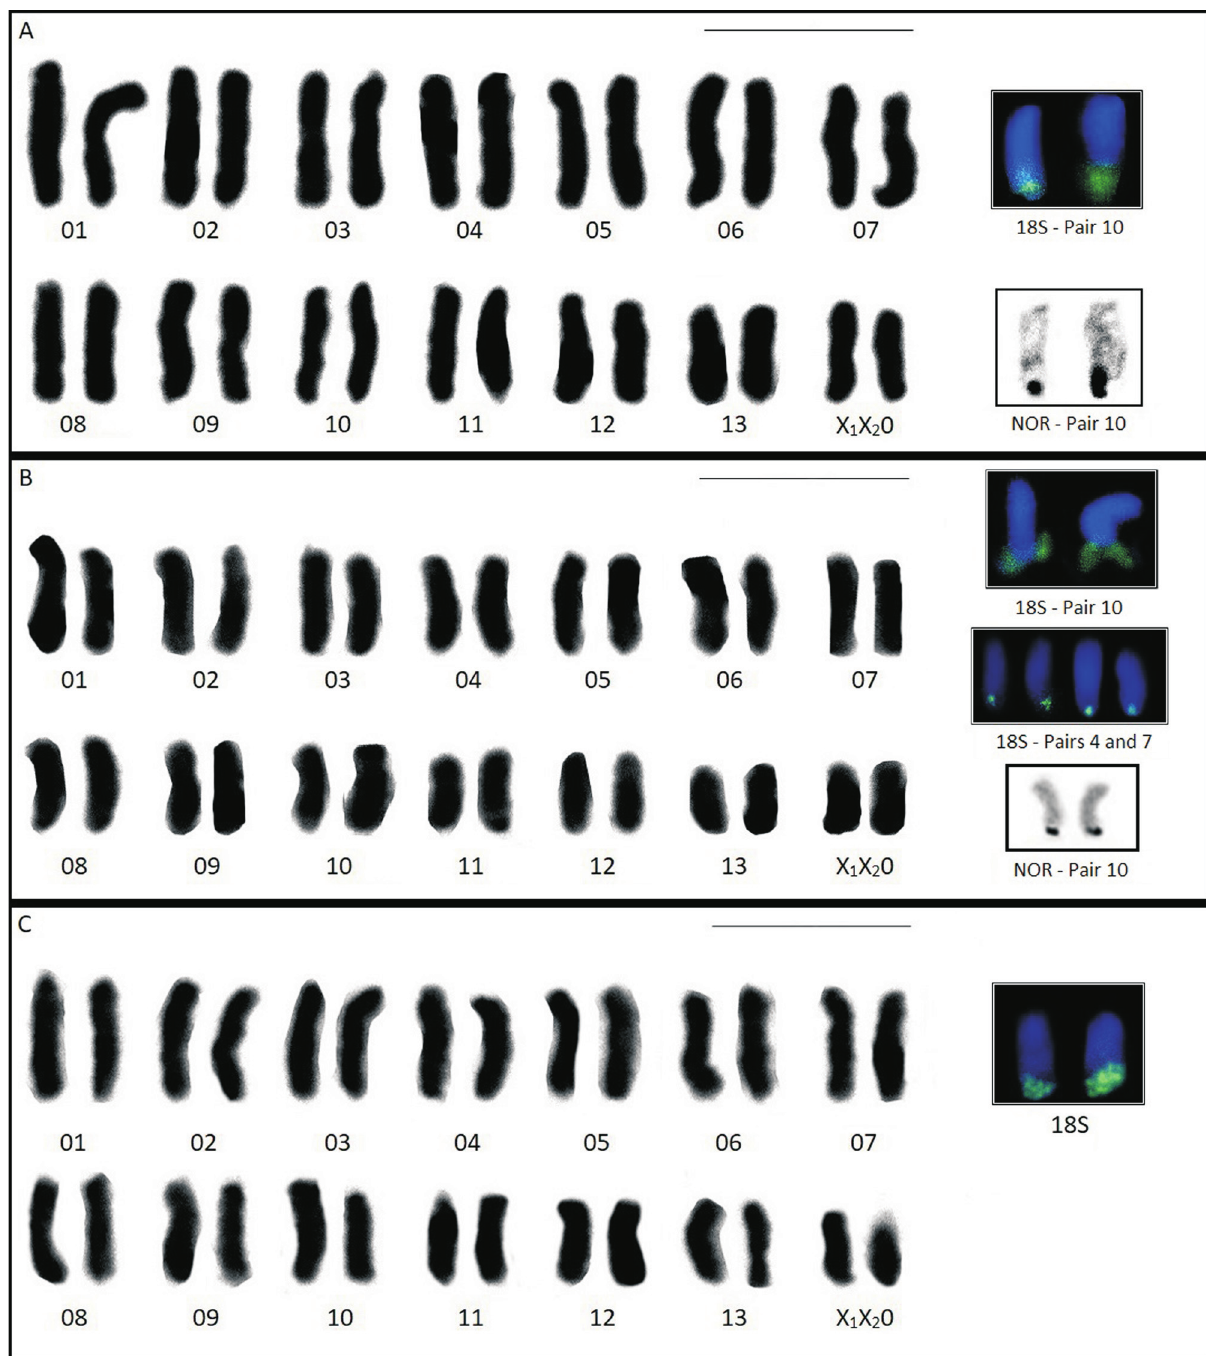
Figure2 -Karyotypesofthestudiedspecies:(A) Ctenusamphora ;(B) C.crulsi and(C) C.villasboasi showingnucleolarpairmarkedbysilvernitrateim- pregnation and FISH with 18S rDNA (Green marks). Scale= 10 (cid:2) m. One C. crulsi individual from the Ducke Reserve presented four labeled chromo- somes (pairs 4 and 7) (Figure 1B -